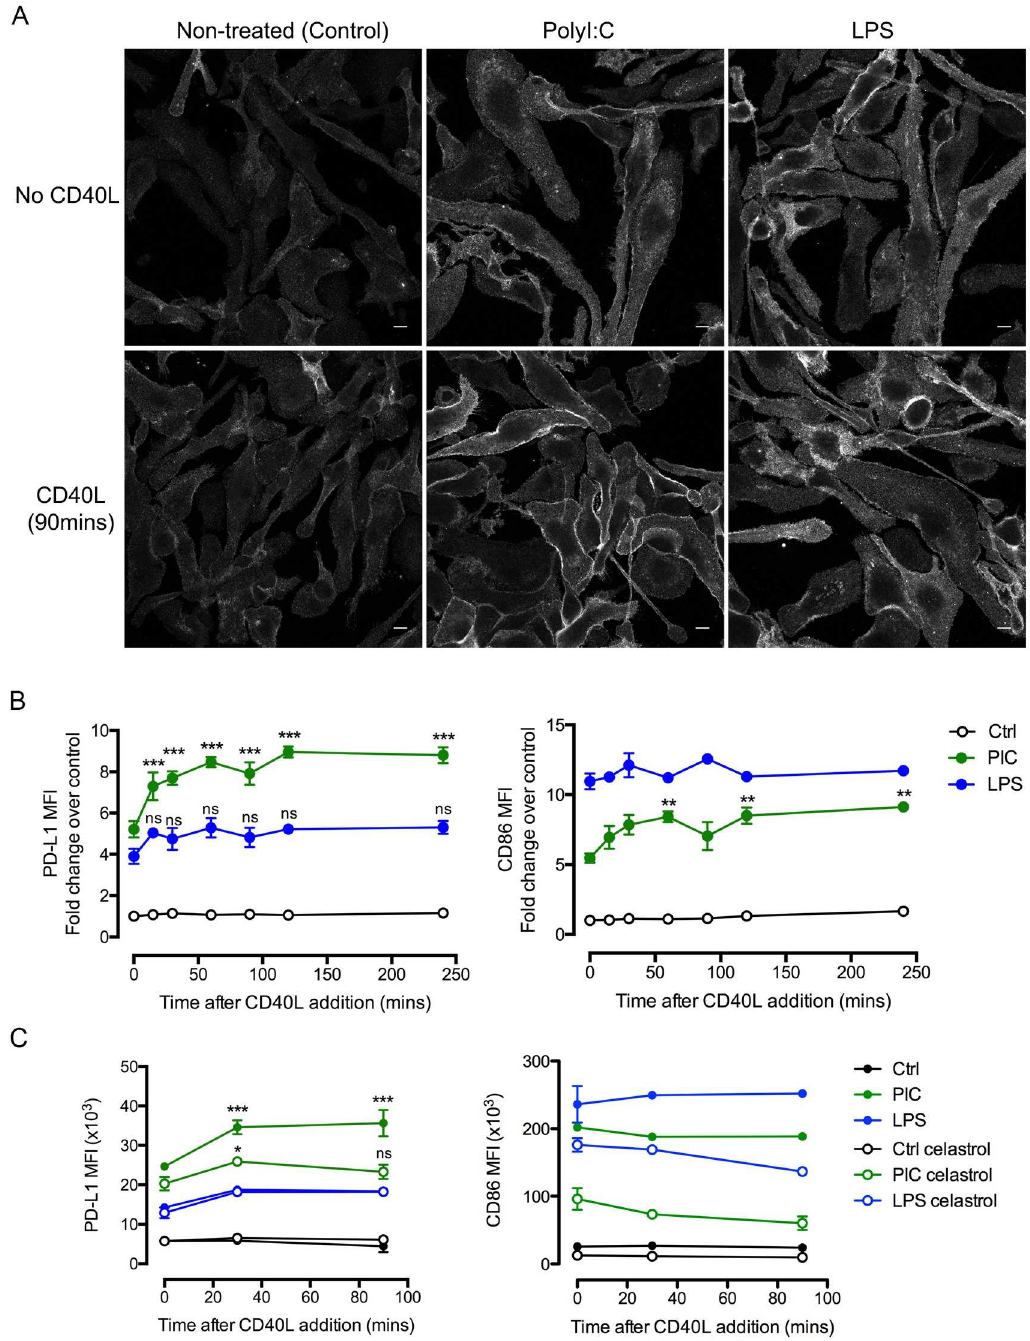
Fig 4. CD40L signalling induces the re-distribution of PD-L1 to the cell surfacein polyI:C-treated DCs. ( A ) PD-L1 expressionon treated DCs. DCs were treated with nothing(Control), polyI:C (25 μ g/mL) or LPS (10 ng/ml) for 20 h followedby incubationwith medium alone (no CD40L)or with rCD40L-Fc (500 ng/mL) for 90 min. PD-L1 expression was analysedby confocalmicroscopy. Scale bar is 10 μ m.Images are a single confocalplane. ( B ) Translocation of PD-L1 to the surface. DCs treated as abovewere incubatedwith rCD40L-Fc for the indicatedtimes. Surface expression of PD-L1 (left panel)and CD86 (right panel)was evaluatedby flow cytometry. Data is representedas a fold change over expressionvalues at time 0 of non-treated(Ctrl) DCs. ( C ) DCs stimulatedas above were incubatedwith celastrol (3 μ M) for 1hr before additionof rCD40L-Fcfor the indicatedtimes. Surface expressionof PD-L1 (left panel)and CD86 (right panel)were evaluatedby FACS. Data in B and C are a compilation of 5 and 3